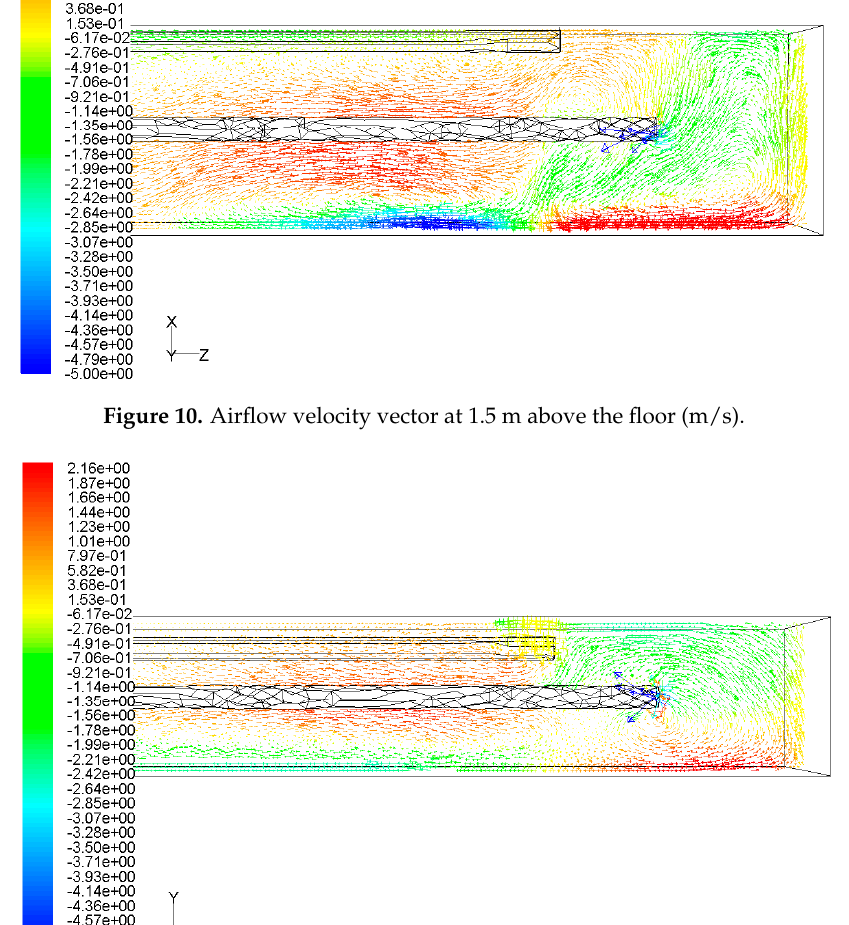
Figure 11. Airflow velocity vector 2 m away from the side wall (m/s).